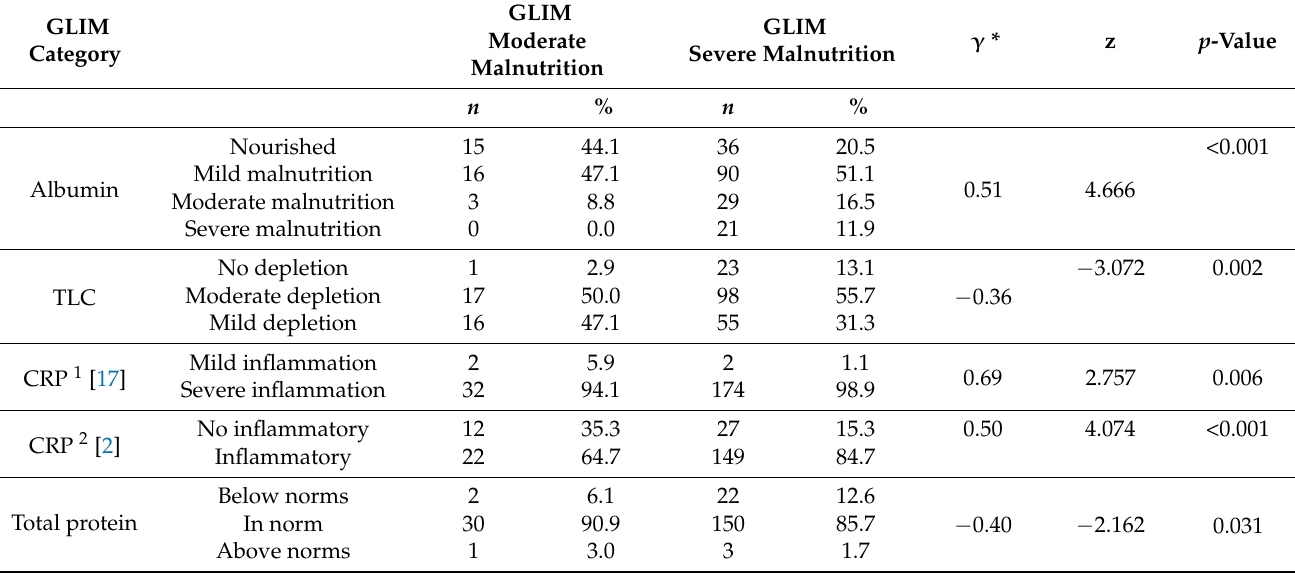
Table 7. Result of Goodman Kruskal’s gamma correlation of biochemical